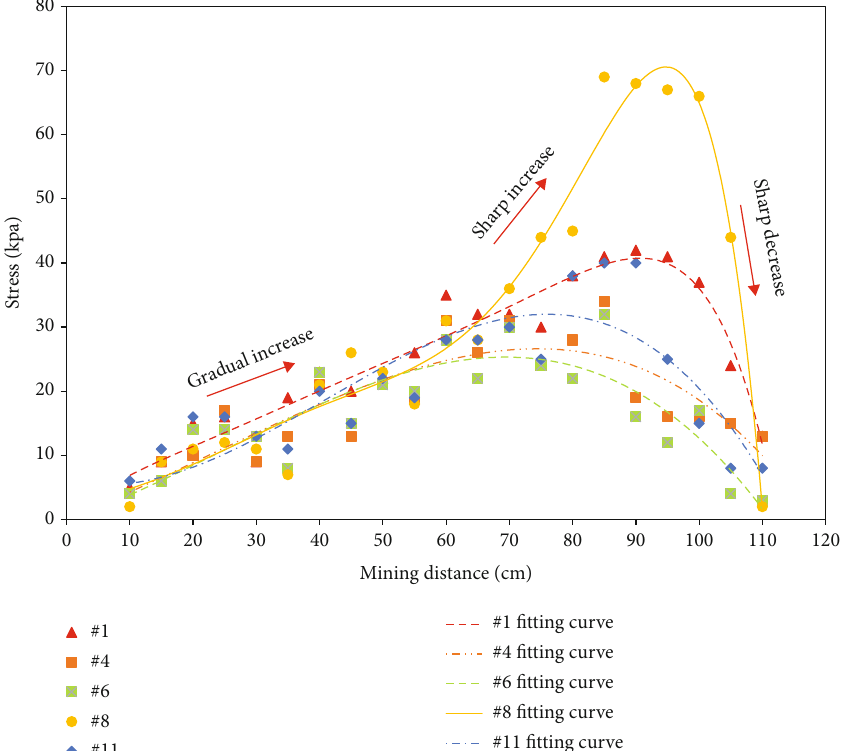
Figure 7: Stress variation detected from stress sensors marked as #1, #4, #6, #8, and #11 during advancement of the mining face.